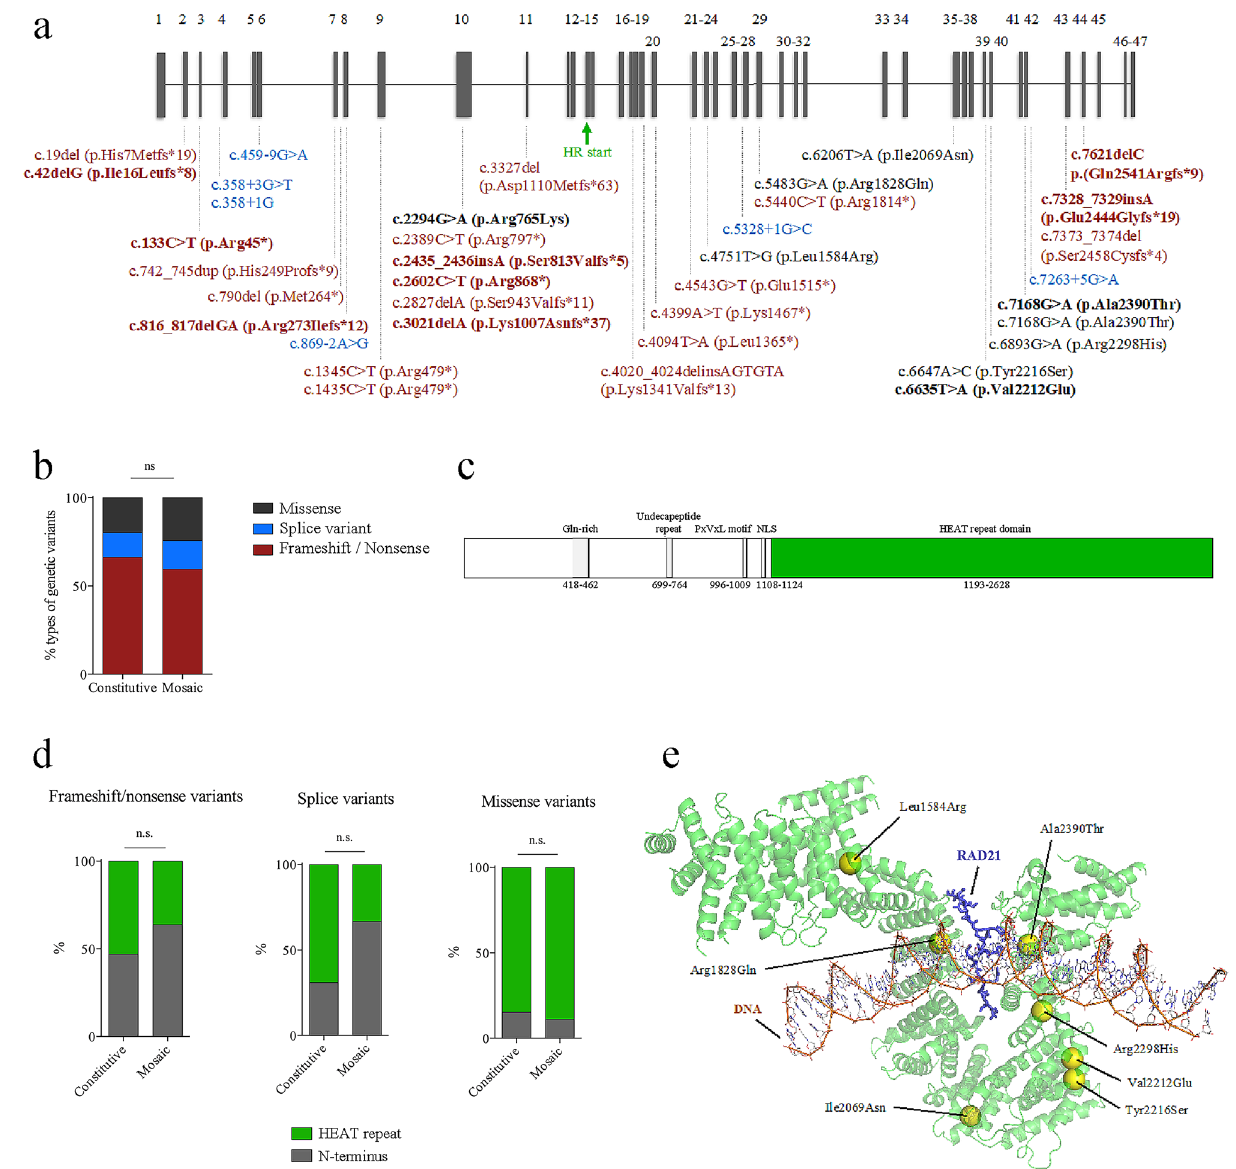
Figure 1. PZM in the NIPBL gene. ( a ) Schematic representation of the NIPBL gene including the localization of PZM variants described in the literature and the newly identified variants (in bold). Nonsense and frameshift variants are shown in red, splice variants in blue, and missense variants in black. Green arrow indicates the starting exon of the HEAT repeat domain (HR). ( b ) Proportion of nonsense/frameshift, splice and missense variants in ClinVar (constitutive, n = 299) and in the mosaic datasets (mosaic, n = 37). ( c ) Domain structure of NIPBL protein. HR domain is shown in green. ( d ) Distribution pattern of constitutive and mosaic variants in N-Terminal motif and HR of NIPBL according to genetic variant type, frameshift/nonsense (constitutive n = 198, mosaic n = 22), splice variants (constitutive n = 42, mosaic n = 6) or missense (constitutive n = 59, mosaic n = 9). (n.s. p > 0.05, ** p < 0.01, *** p < 0.001, Chi-square test). ( e ) 3D representation of NIPBL HR (green) in close contact with a small segment of RAD21 (blue) and a DNA molecule, as described in the Protein Data Bank structure id: 6WGE. Position of variants Leu1584Arg, Arg1828Gln, Ile2069Asn, Val2212Glu, Tyr2216Ser, Arg2298His and Ala2390Thr is indicated (yellow CdLS. Of the 43 patients included, 39 were molecularly diagnosed (90.7%, 39/43). By Sanger sequencing and/or NGS targeted panel on DNA from blood, heterozygous causative variants in cohesin-related genes were found in 31 patients (72.1%, 31/43; of which 22/31 in NIPBL ; 4/31 in SMC1A ; 2/31 in HDAC8 ; 1/31 in SMC3 ; 1/31 in RAD21 ; and 1/31 in ANKRD11 ) 28–32 . The 31 causative variants identified in blood were confirmed in all patients by Sanger sequencing in at least one additional biological sample (saliva, buccal swabs or fibroblasts), confirming that the variants identified were all constitutive. By array CGH and MLPA, the genetic cause of the disorder was detected in four patients. Two of them presented a microdeletion involving the RAD21 33 and ARID1B 23 genes,